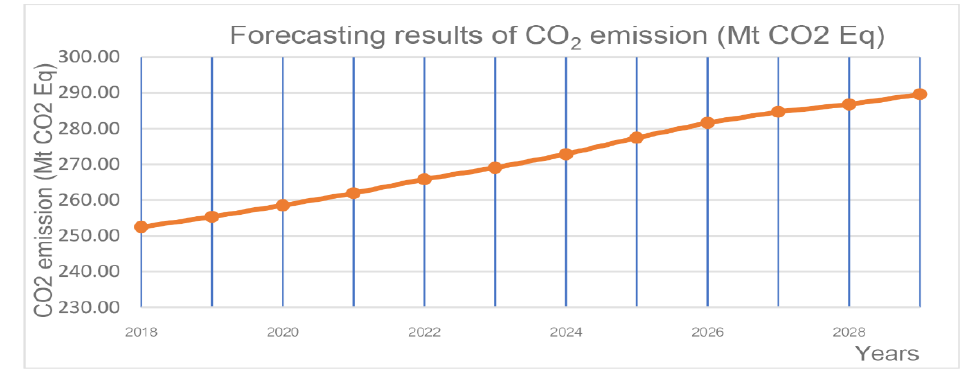
Figure 2 . The forecasting results of CO 2 emissions from 2018 to 2029 in Thailand. Figure 2. The forecasting results of CO